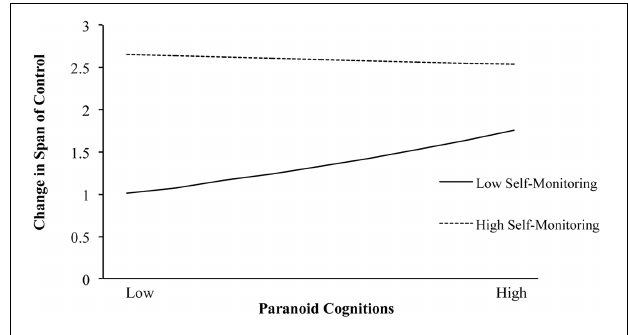
FIGURE 1 | The interactive effects of paranoid cognitions and self-monitoring on changes in span of control.